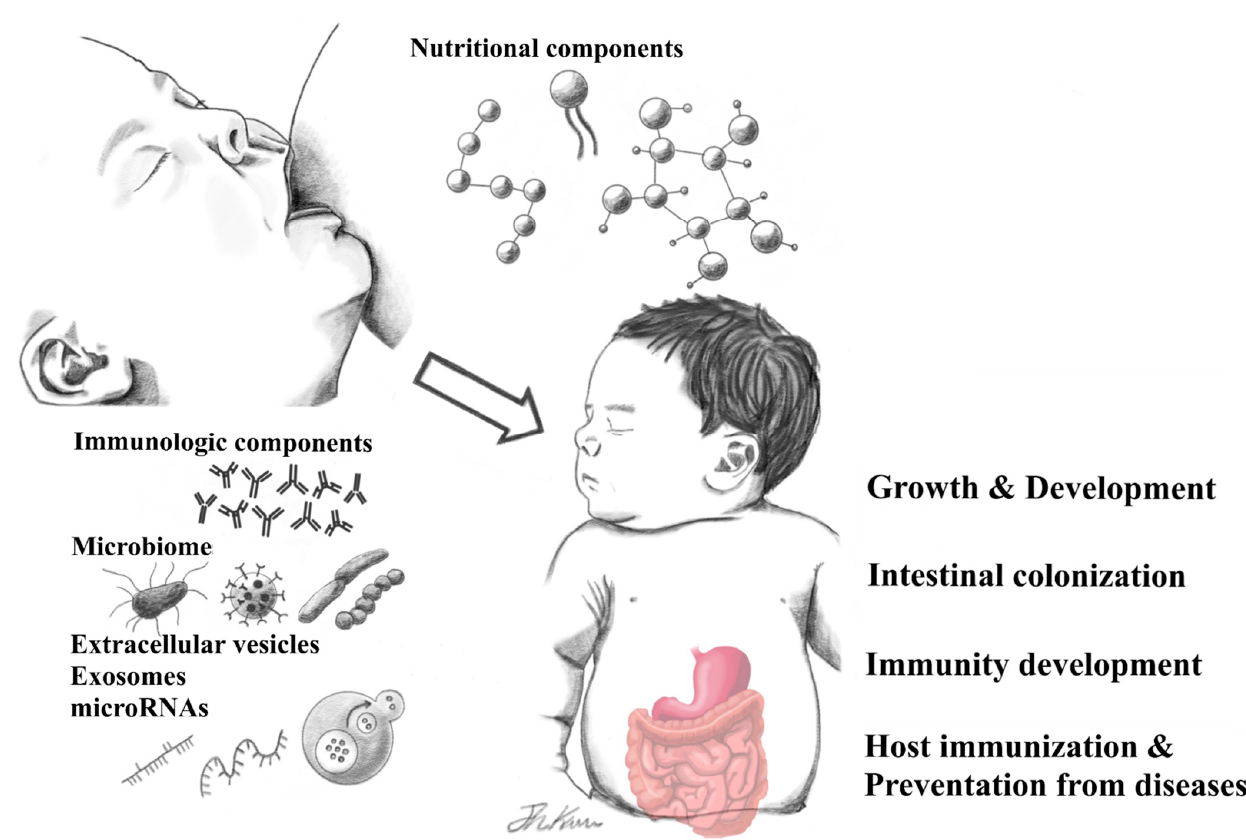
Figure 1. Human breast milk-derived components and their health